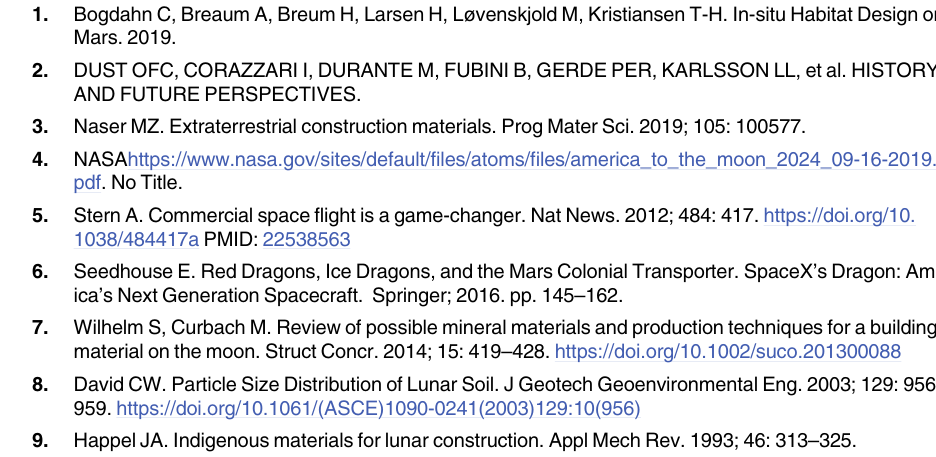
S1 Fig. Screening of temporal evolution of ammonium ion concentration with the supple- mentation of different concentration of NiCl (F denotes flask condition and S in the